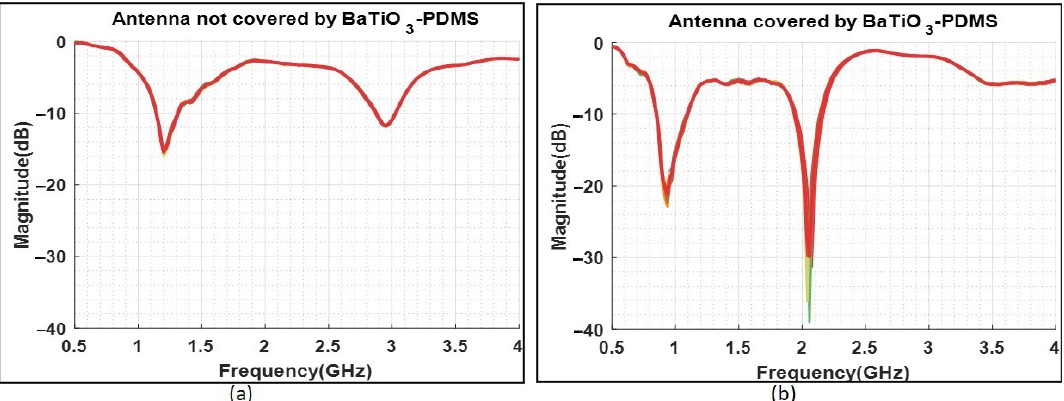
Figure 9. ( a ) S 11 measurements while the antenna is not covered by the matching medium. ( b ) S 11 measurements when the antenna is covered by the matching medium. In both cases, the measurements are performed 10 times and the red bold line is the mean of all